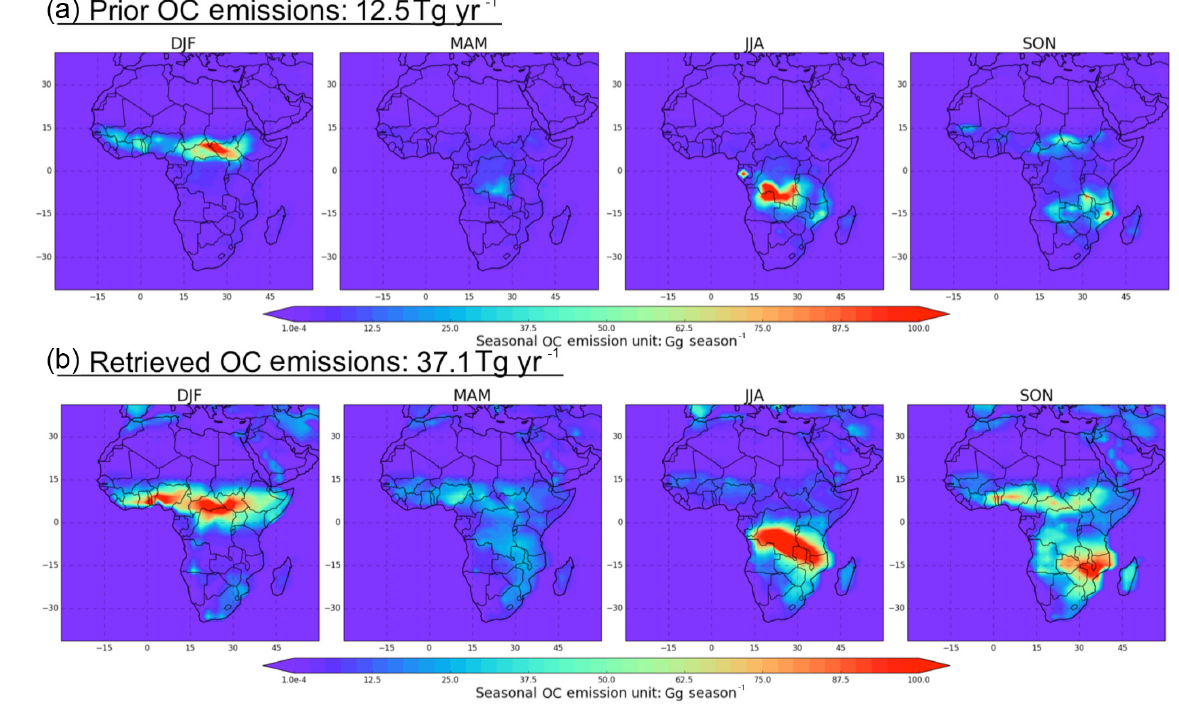
Figure 16. Spatial distribution of seasonal OC emissions: (a) prior model OC emissions using GFED3 and Bond inventories and (b) retrieved OC emissions.